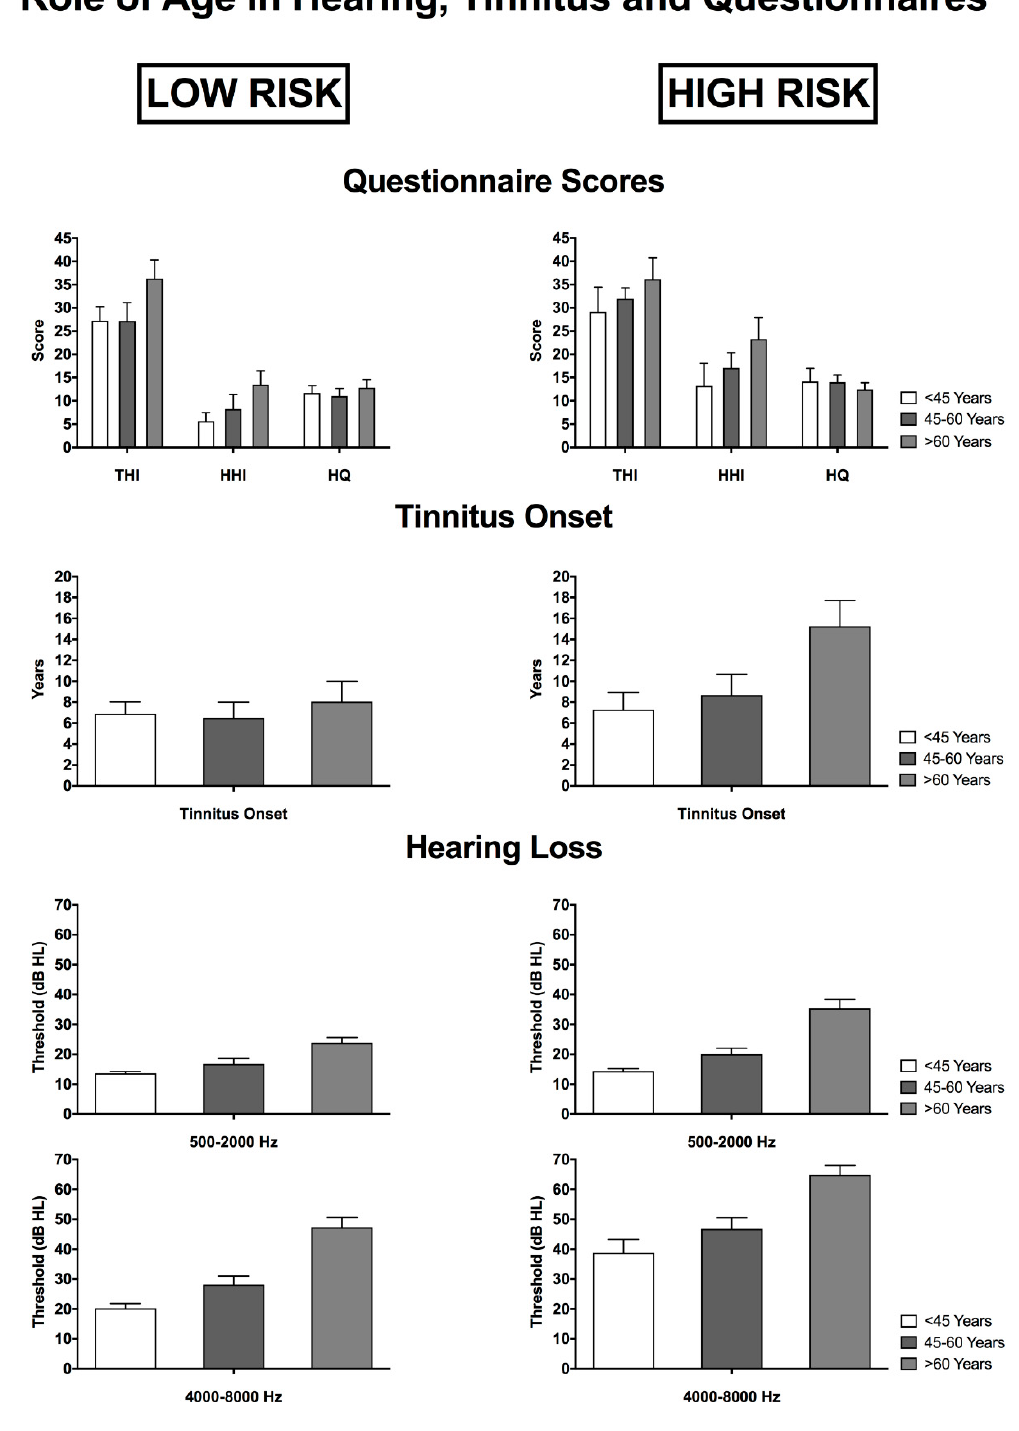
Figure 3. Relationship between age of the patient and hearing loss (PTA), tinnitus onset and self-administered questionnaire scores (HHI, THI, HQ) sorted by LOW-RISK and HIGH-RISK groups.